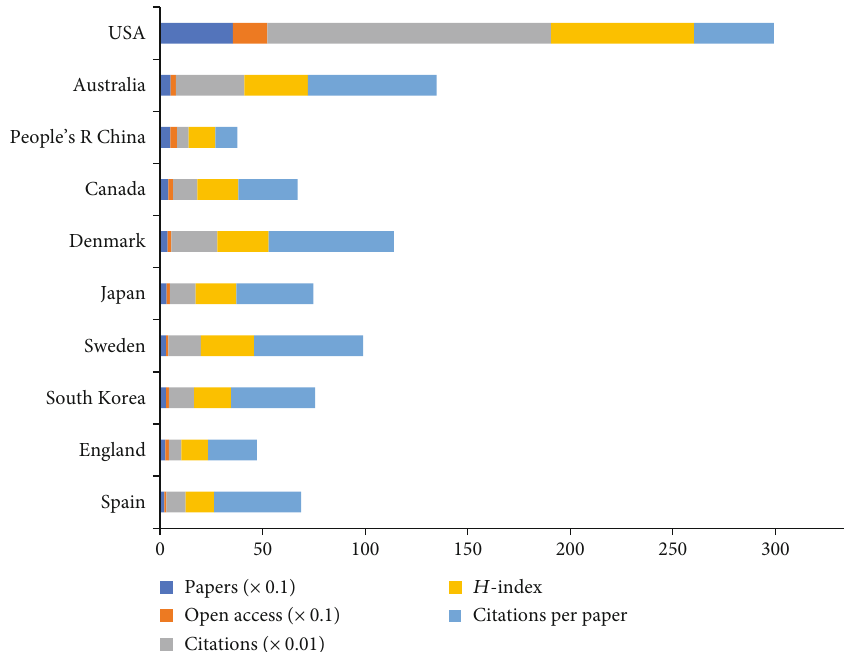
Figure 6: The number of papers, citations, citations per paper, and open-access papers and H -index of the top 10